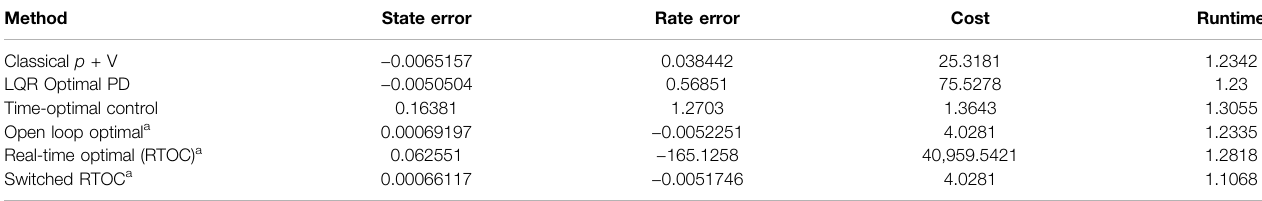
TABLE 7 | One-thousand-run (respectively) Monte Carlo analysis.